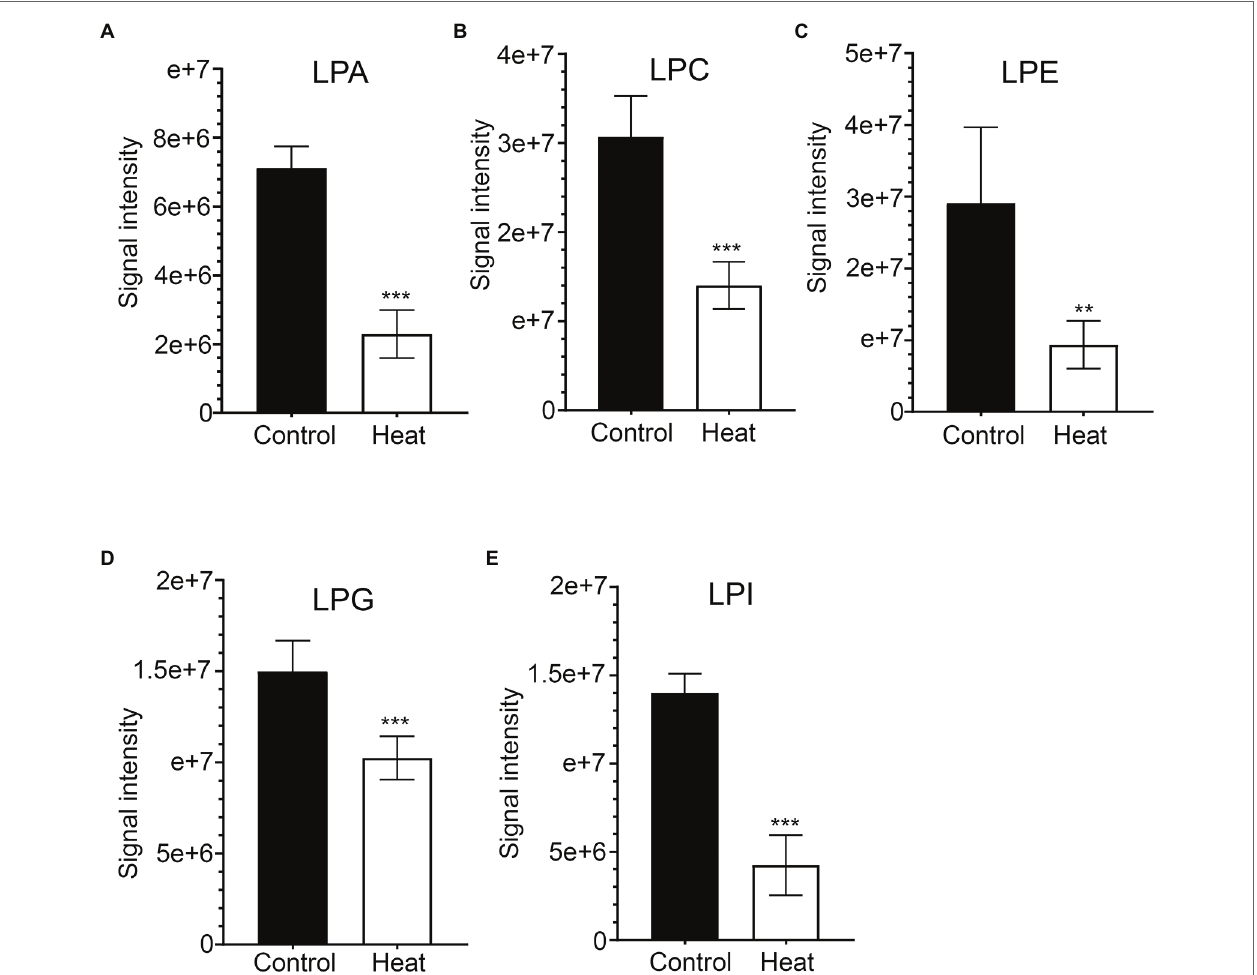
FIGURE 6 | Changes in the levels of lysophospholipid molecular species in response to heat stress. Fully extended leaves detached from 173-d-old plants of B. grandis were at control condition (22 ° C for 2 h) or challenged with heat stress (45 ° C for 2 h). (A) LPA, lysophosphatidic acid; (B) LPC,